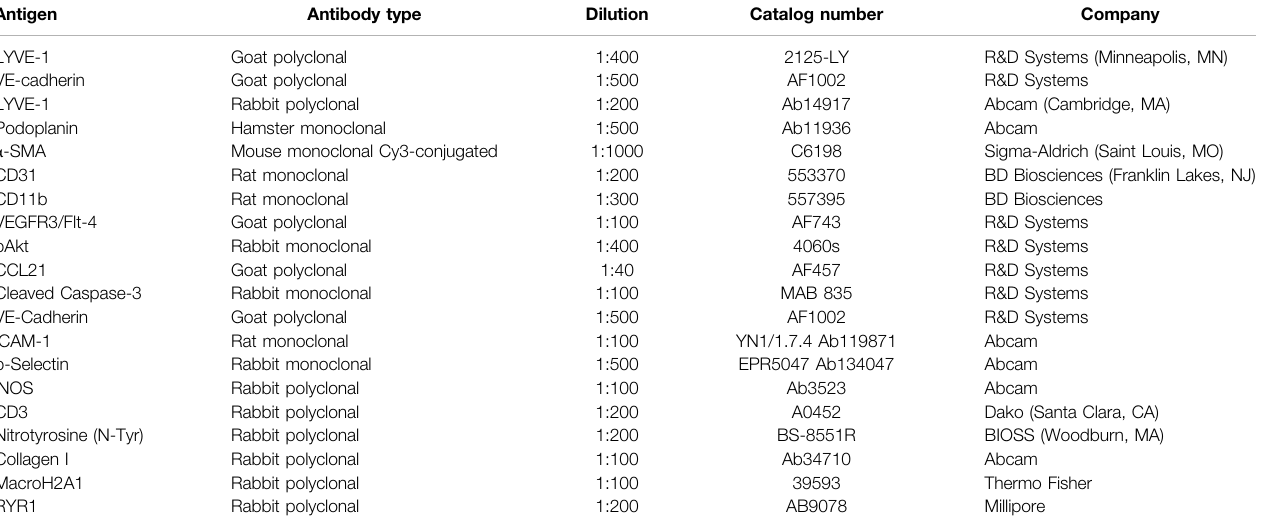
TABLE 1 | Antibodies used for